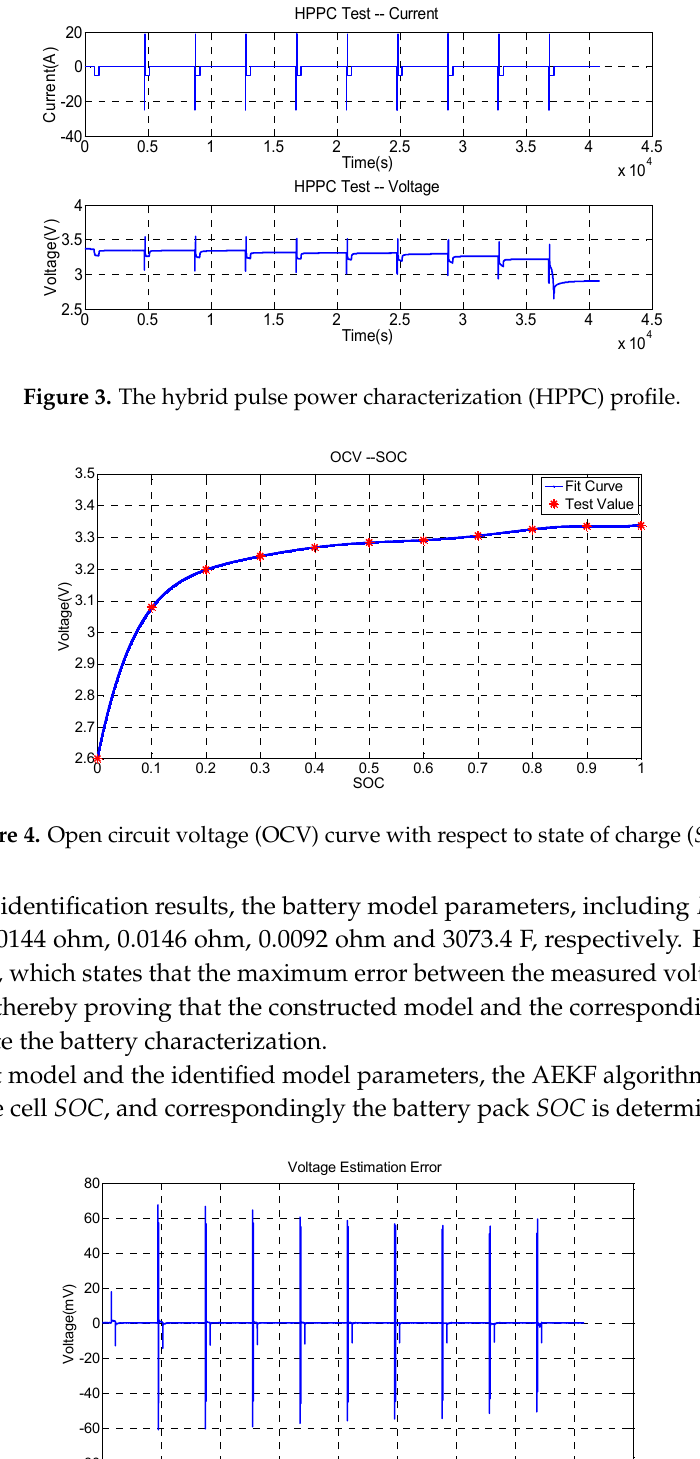
Figure 5. Voltage estimation error.